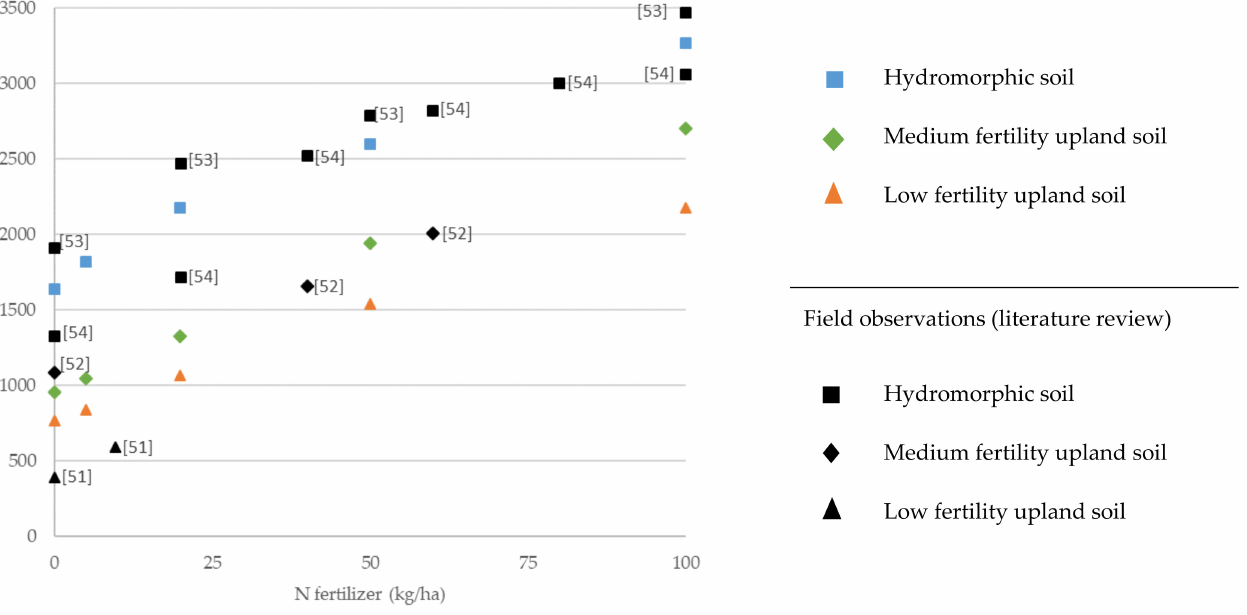
Figure 1. Sorghum simulated vs. published observed grain yields per fertilizer input level and soil fertility class. Numbers within brackets [] ([51–54]) indicate the reference of the publication from which data was